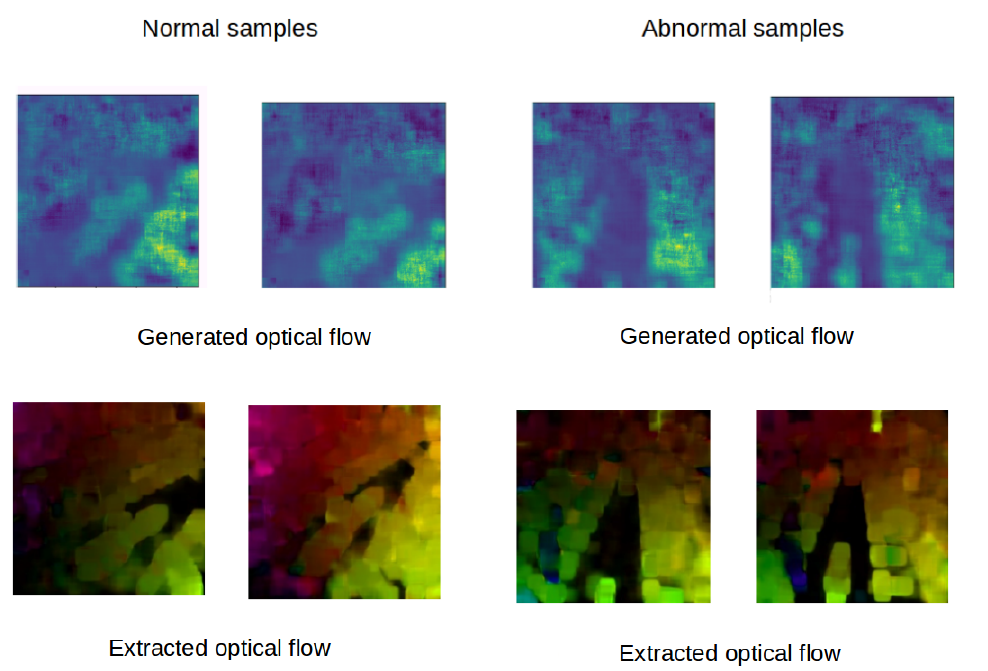
Figure 6. Samples of optical flow generated by our architecture.